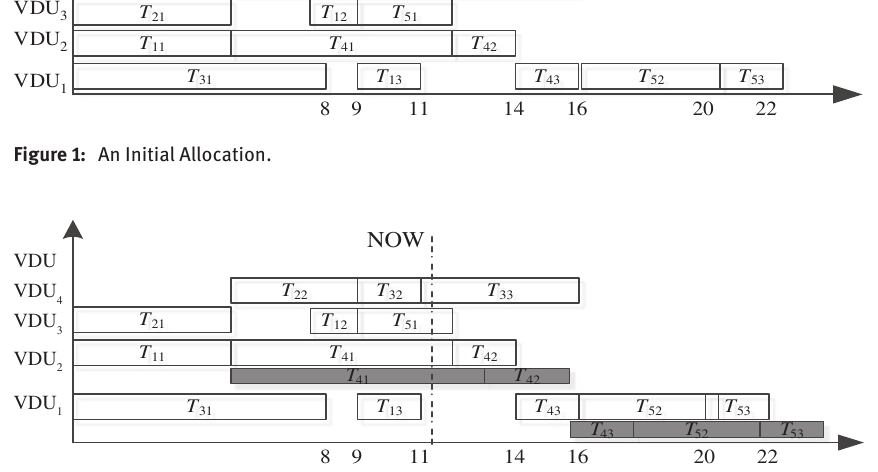
Figure 2: Diagram of Task Allocating